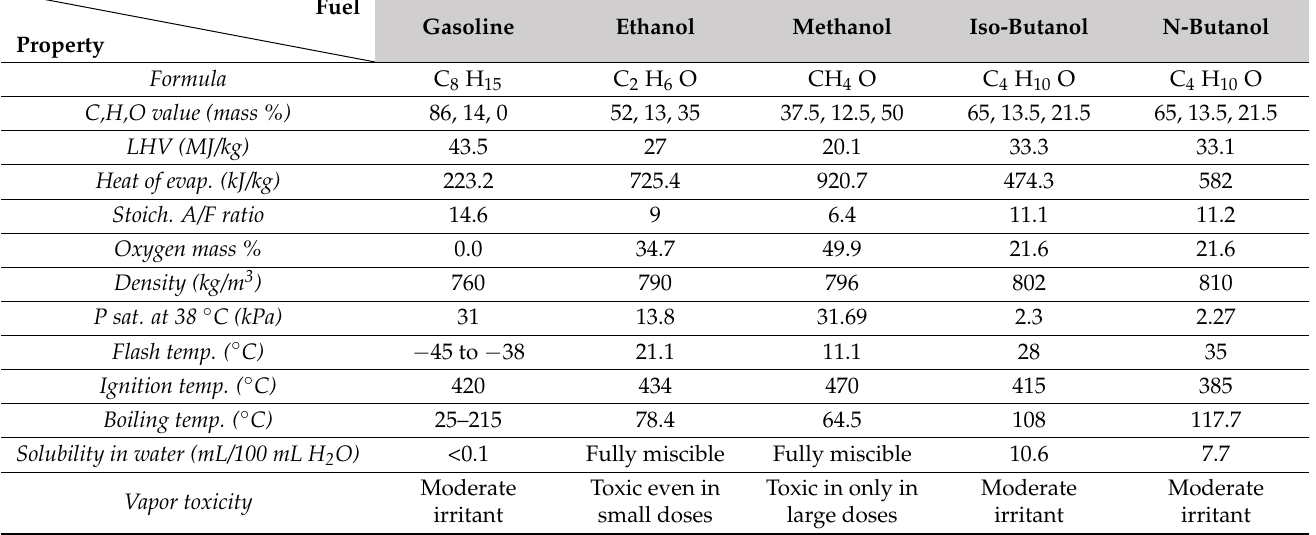
Table 2. Fuel properties